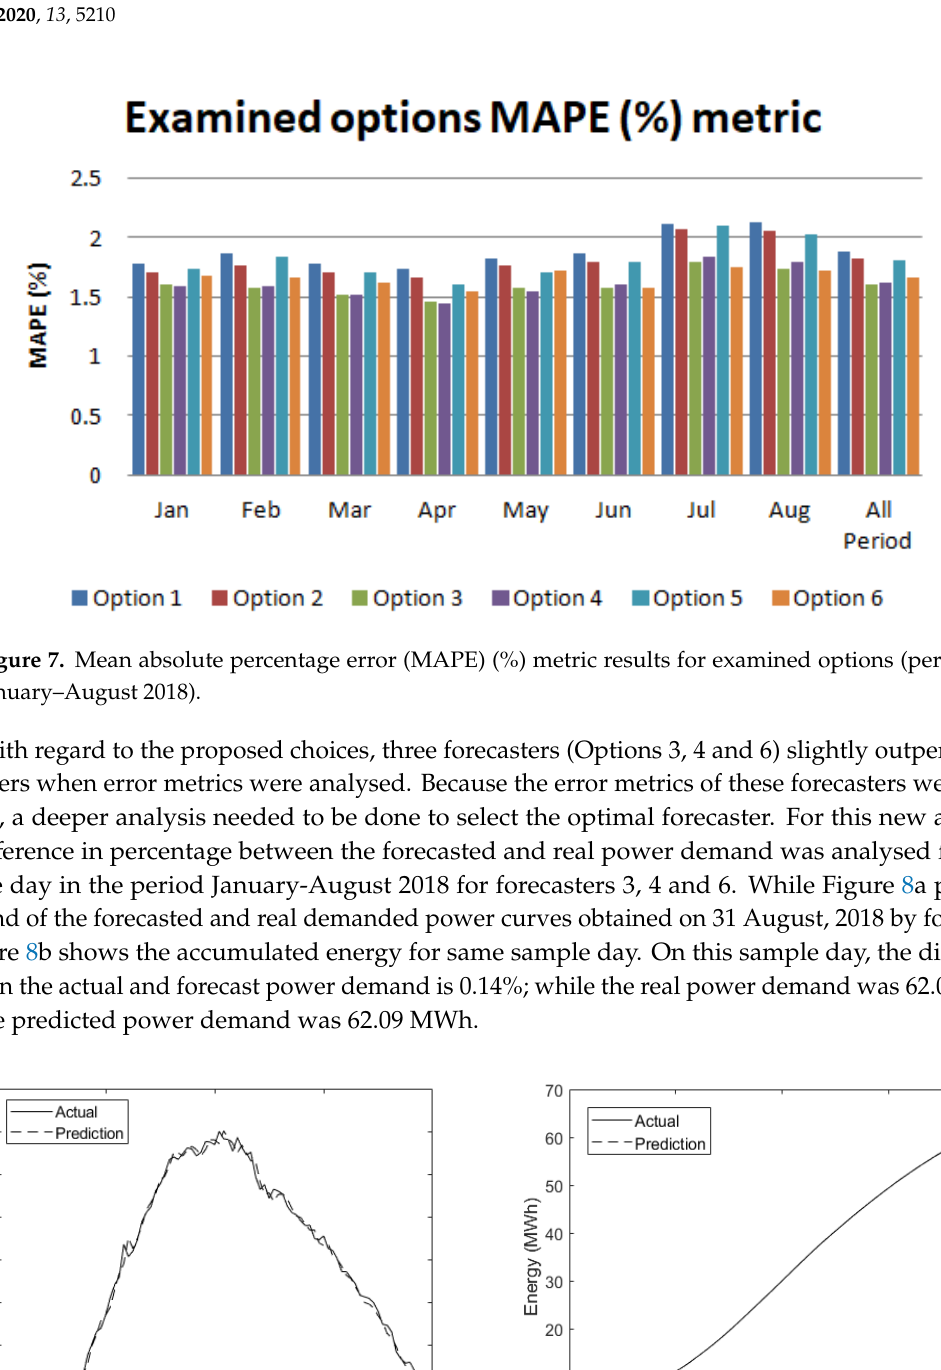
Figure 8. ( a ) Difference between real and predicted power demand on 31 August 2018 ( b ) accumulated energy.